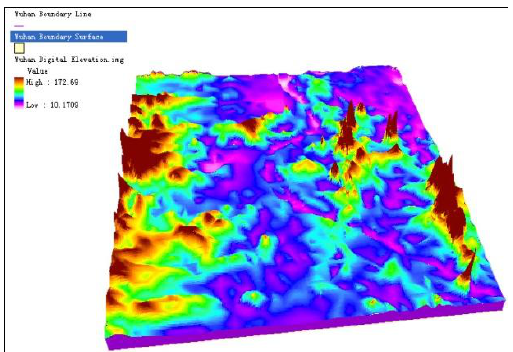
Figure 5.DEM data in Wuhan